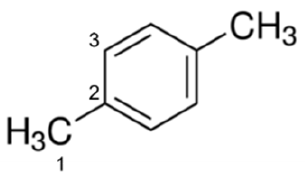
Figure 8. Differentiation of p- xylene carbon atoms detectable by T1 13 C NMR. The mean T1 ads/ T1 bulk ratio (0.82–0.83) confirmed that p- xylene is adsorbed on bot bare GNP and Pd/GNP. The lowest values of T1 ads /T1 bulk were obtained for C 2 (Table 6, second line), while the highest values of T1 ads /T1 bulk are those related to the carbon atom of the methyl group (C 1 ), indicating its weaker adsorption compared to the aromatic carbon atoms. Table 6. p -Xylene T1 bulk and T1 ads resulting from analysis of the inversion recovery curves from 13 C NMR spectra (600 MHz).